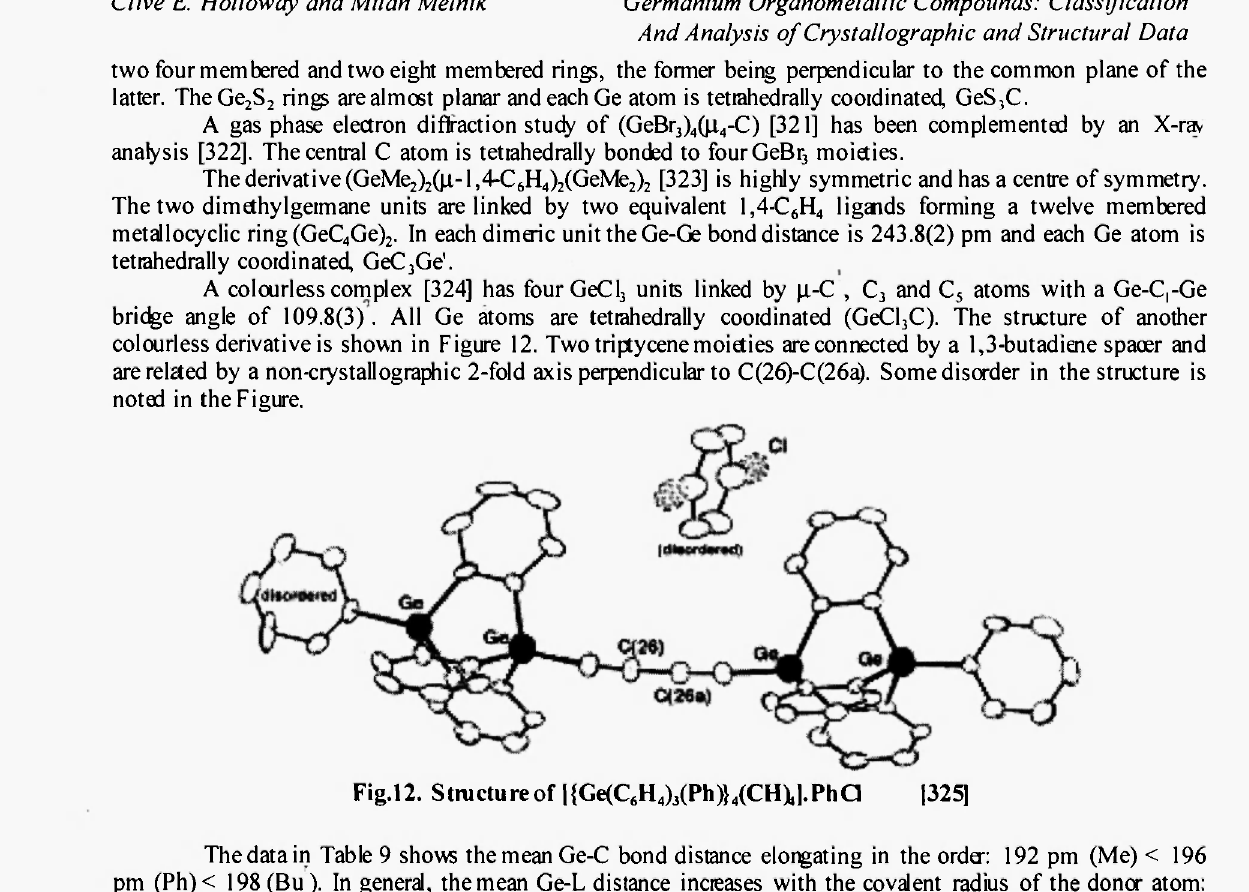
Fig.12. S tra ctu re of I {Ge(C 6 H 4 ) 3 (Ph)} 4 (CH),]. Ph Q